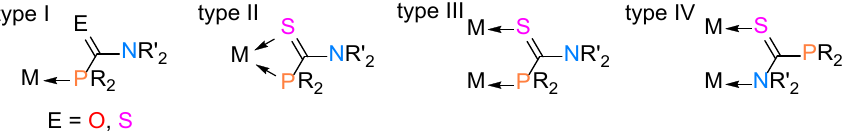
Figure 1. Typical coordination modes for phosphinecarboxamide and